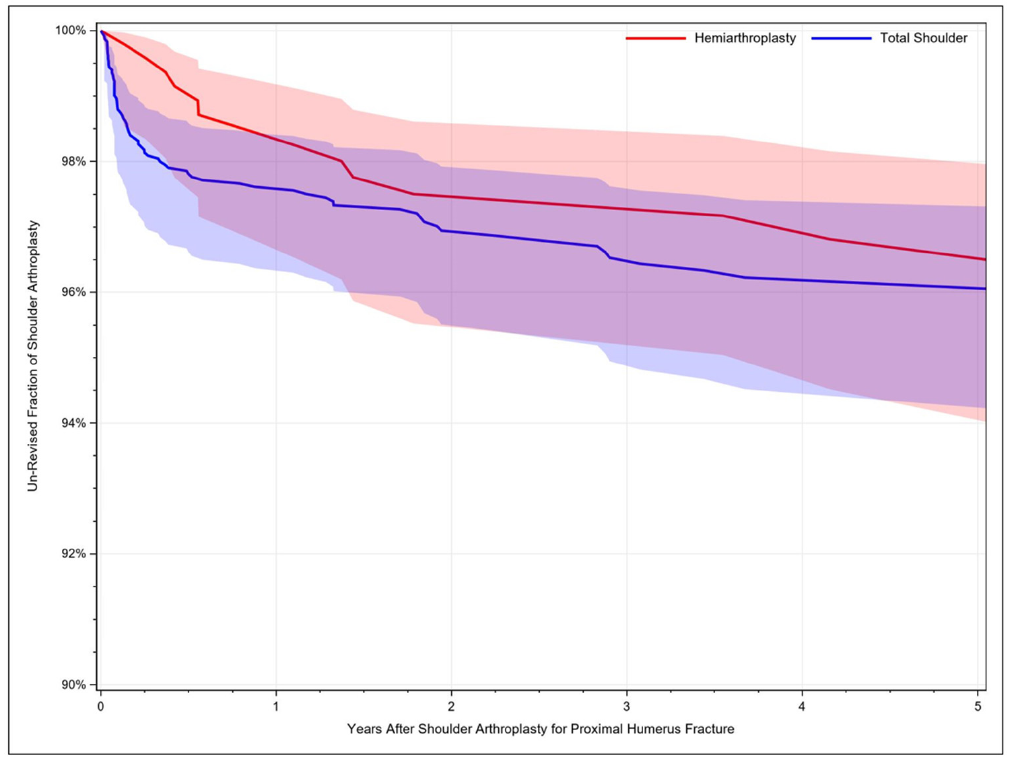
Figure 1. Comparison of revision rates after total shoulder arthroplasty by indication. The unrevised fraction of patients with osteoarthritis is shown in green, patients receiving treatment for proximal humerus fractures in blue and patients receiving rotator cuff-related arthroplasty in red.